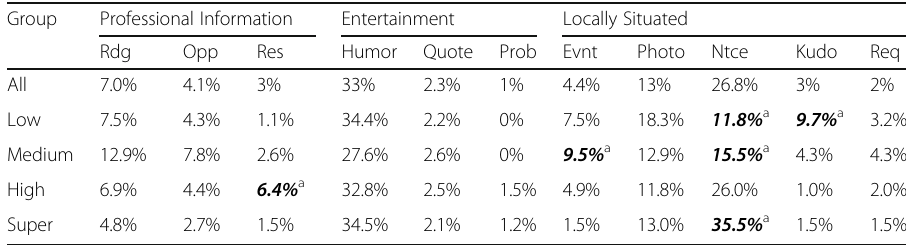
Table 5 Percentages of category interactions per user-level Group Professional Information Entertainment Locally